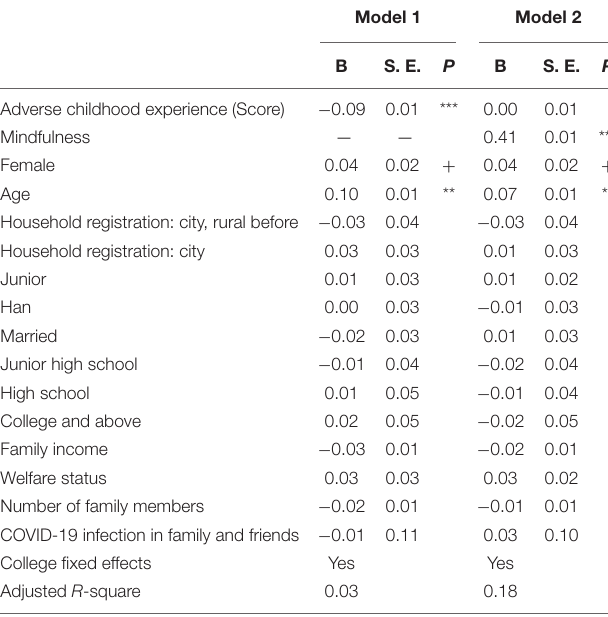
TABLE 3 | Regression analysis of grit.